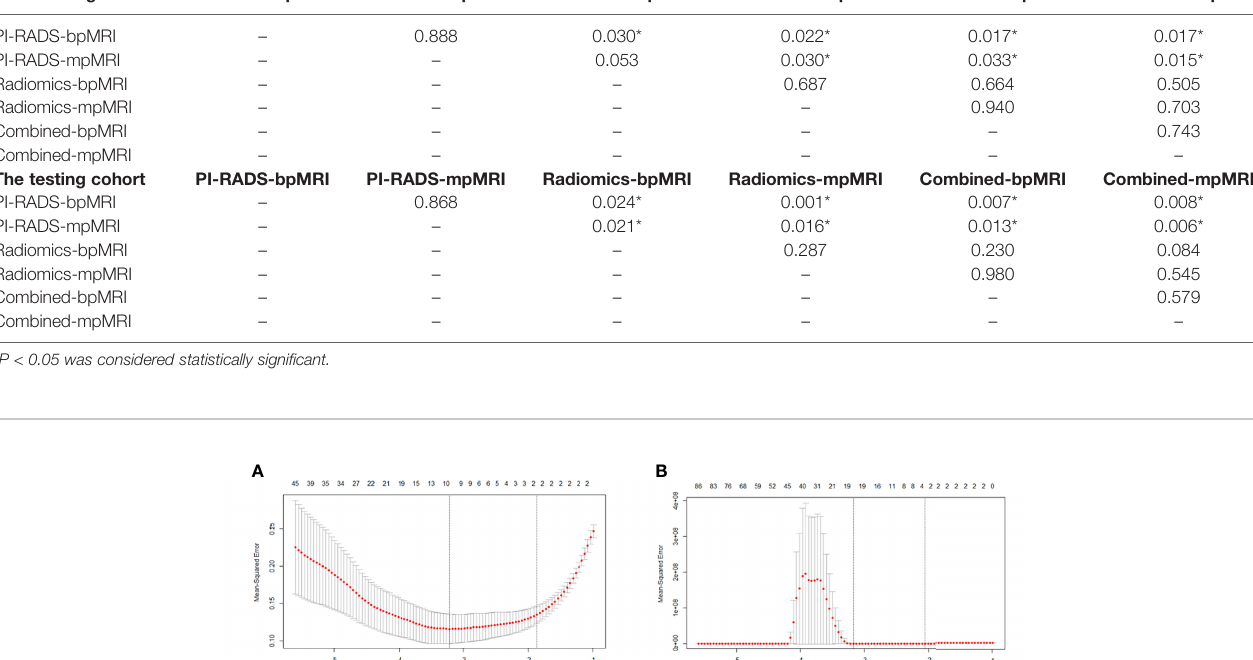
TABLE 5 | Delong test of the PI-RADS, radiomics, and PI-RADS-radiomics combined models in the training cohort and testing cohort. The Training Cohort PI-RADS-bpMRI PI-RADS-mpMRI